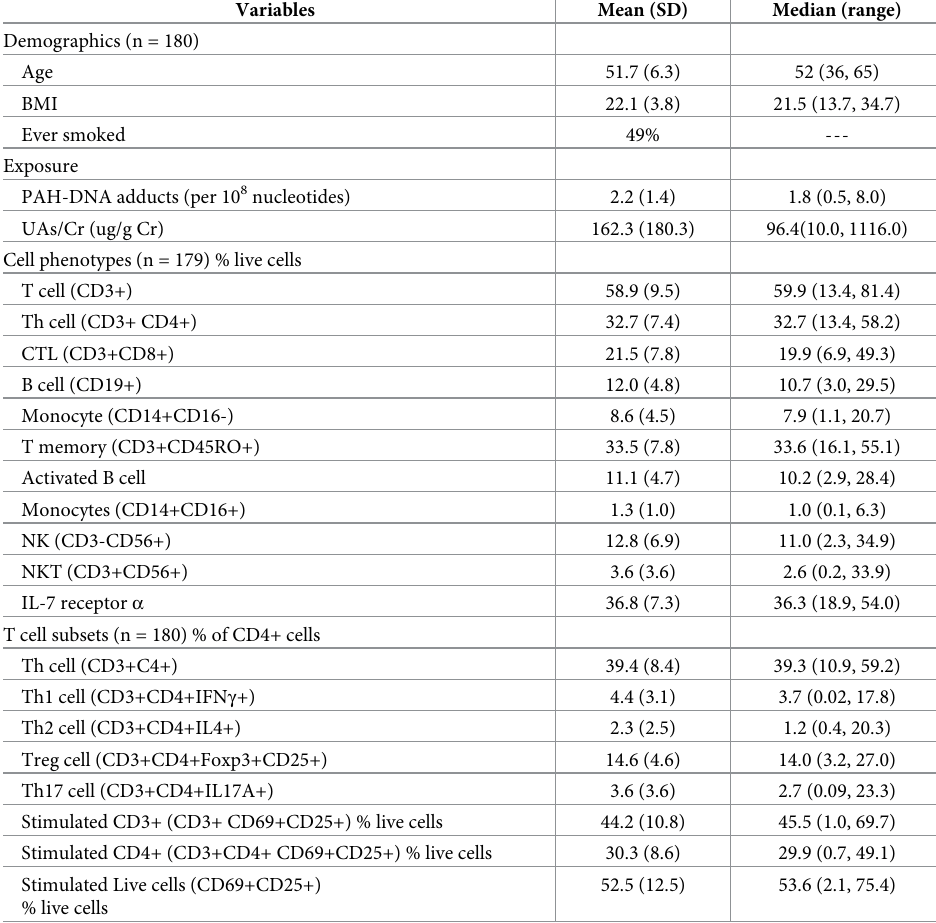
Table 1. Demographics, exposure, immune cell phenotypes and T cell subsets of a male Bangladeshi Study Cohort. Variables Mean (SD) Median